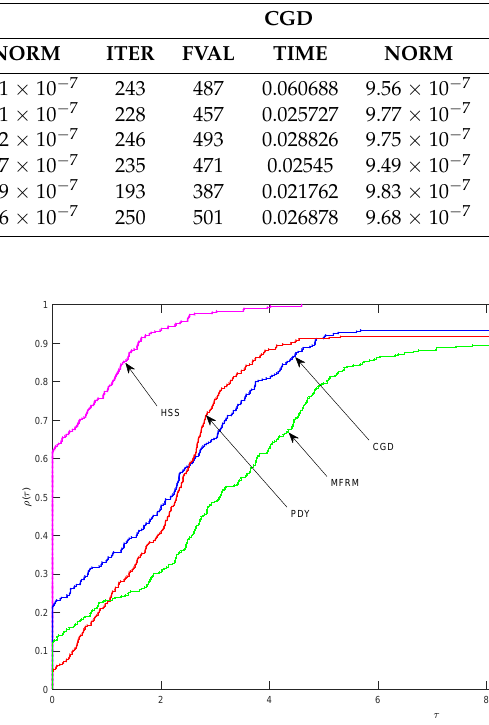
Table 11. Test results obtained by the four solvers for Problem 11.